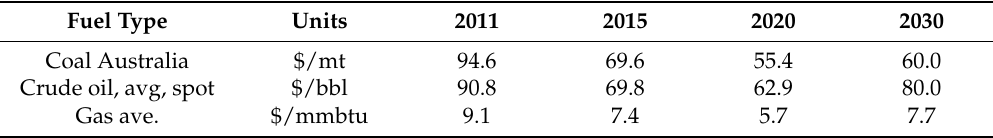
Table 3. Fossil fuel prices between 2011 and